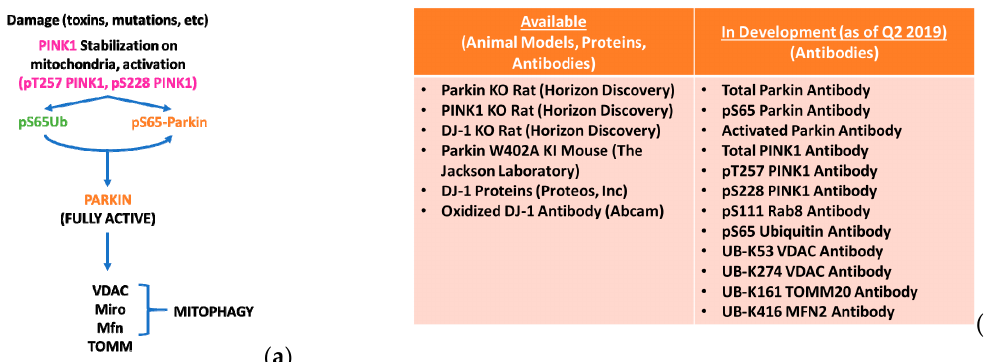
Figure 1. PTEN-Induced Putative Kinase 1 (PINK1) and Parkin pathway preclinical tools and animal models ( a ) The multiple players within the PINK1-Parkin-mitophagy pathway are indicated. Upon mitochondrial damage, PINK1 is stabilized on the mitochondrial membrane and gets activated. Once active, PINK1 phosphorylates ubiquitin that in turn binds to Parkin and causes Parkin translocation to the mitochondria. PINK1 also phosphorylates Parkin in the mitochondria that results in a conformational change in Parkin and renders it fully active. Parkin then ubiquitinates itself and several other mitochondrial proteins, the most prominent of which are listed in the figure. This labels the damaged mitochondria for degradation by the lysosome (mitophagy); ( b ) The various tools